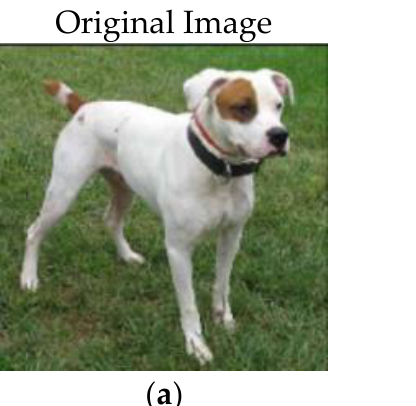
Figure 4. ( a ) Input image; ( b ) output of class activation map (CAM).